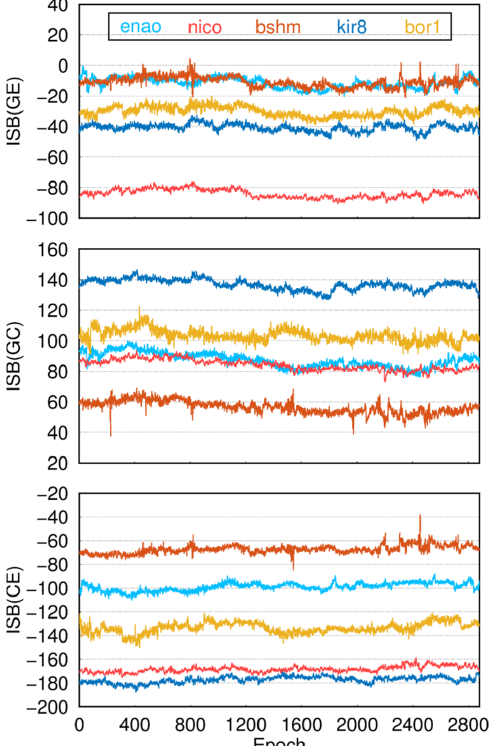
Figure 17. One-day single-frequency ISB of 5 tracking stations equipped with different receivers (1 February 2022).